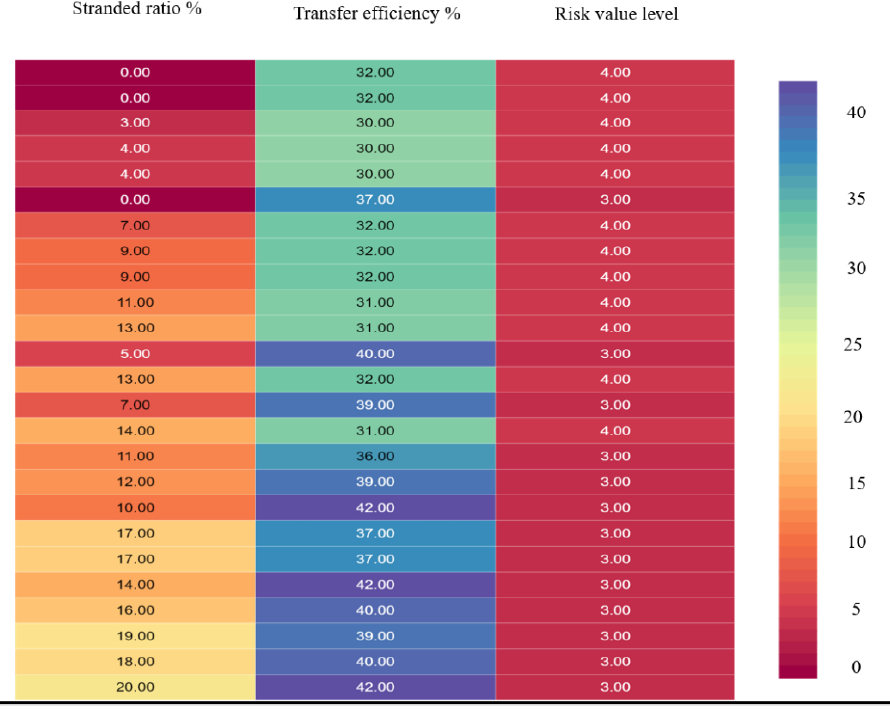
Figure 11. Heat map showing the correlation between the inputs and the risk levels.